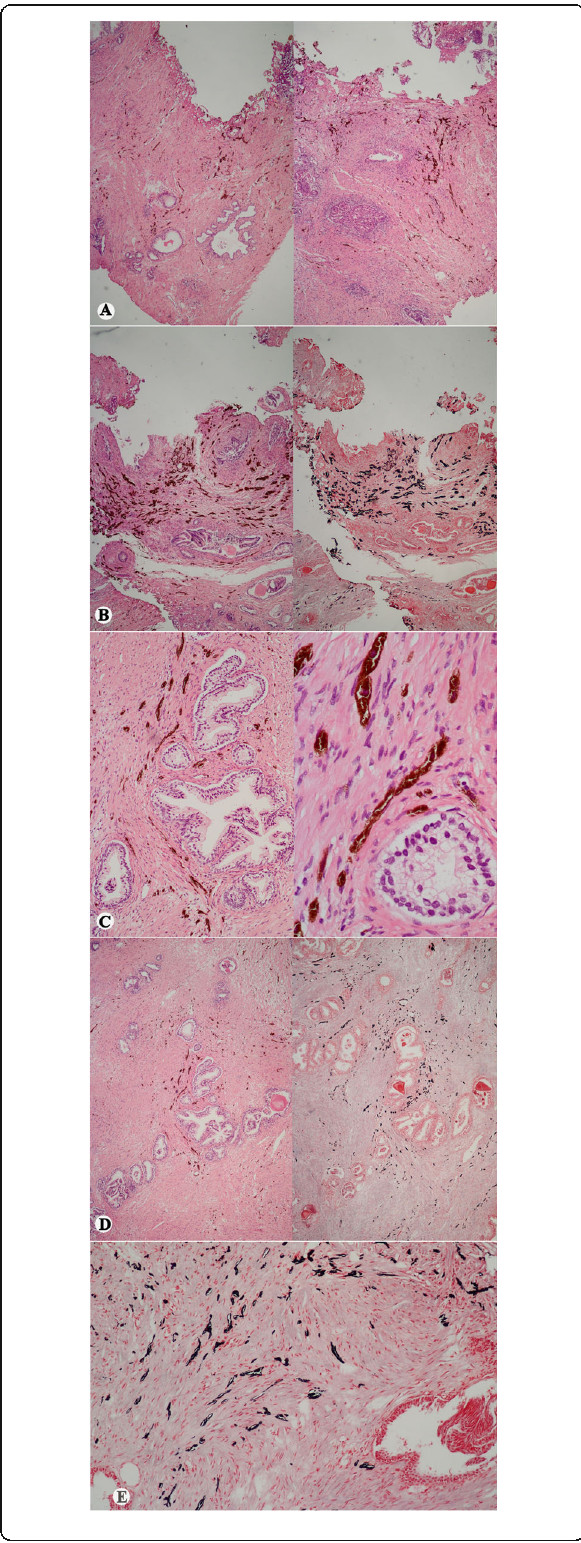
Fig. 1 A prostatic blue nevus in transurethral resection specimen. a Two photomicrographs of the prostate with stromal dendritic melanocytes with dense brown deposits of melanin, intermixed between benign glands (HE, 40x). b Comparison of the same area with HE and Fontana-Masson (40x). c Details of dendritic melanocytes in HE (100x and 400x). d Comparison of other area with HE and Fontana-Masson (40x). E) Detail of dendritic melanocytes stained with Fontana-Masson